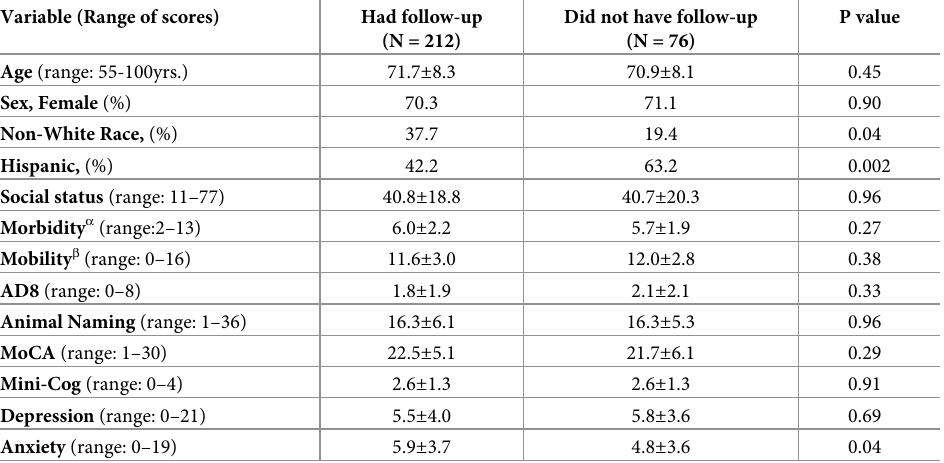
Table 1. Participant characteristics by follow-up